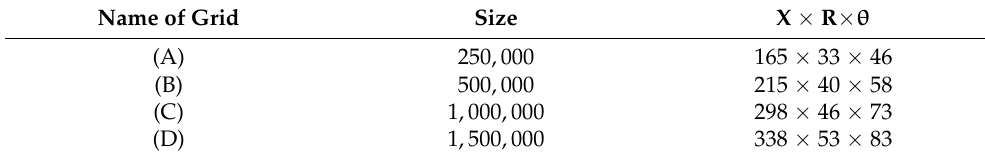
Table 2. Four different sizes of